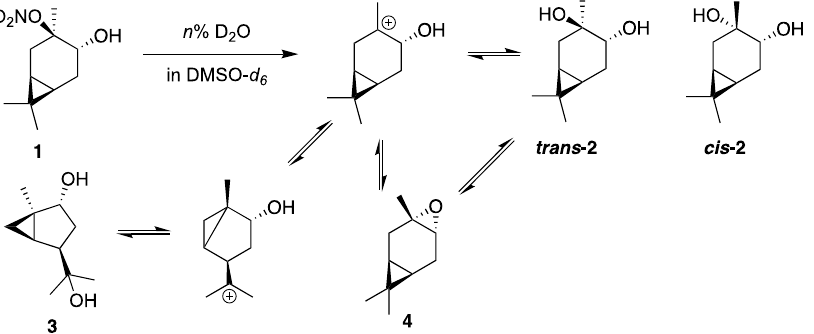
Figure 1. Product formation from CHN 1 in D 2 O/DMSO- d 6 mixtures.